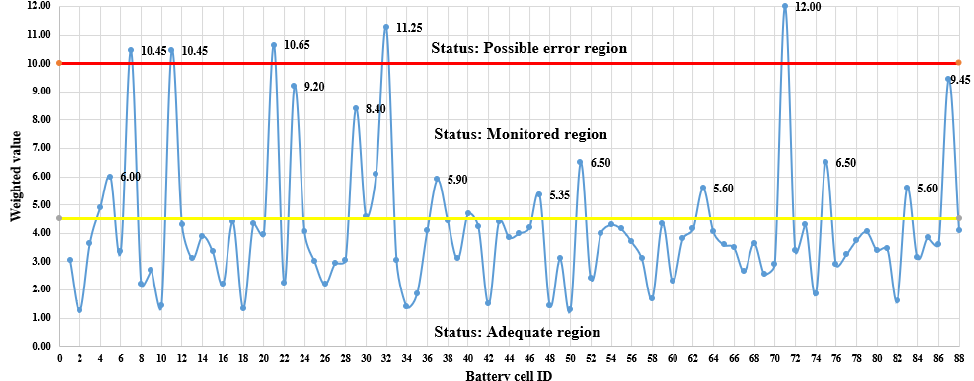
Figure 15. Aggregated error factor assigned to the cell identifier in the cyclical measurement. In Figure 15, the error factor cut-offs are set at 10% and 5% of the data set. The possible error category was assigned to the cell IDs, which were detected with an average voltage higher than 10% based on the aggregate measurement results (results above the red line). Cells flagged for further monitoring were more than 5% but less than 10% below the average voltage based on the summary results (the values between the red and yellow lines). In the adequate region, they were below the mean voltage by less than 5% of the time (values below the yellow line). Based on the outcomes, it can be stated that five dif- ferent cells caused real outliers. The evaluation of the results and comparison with the previous ones will be presented in the discussion section (Section 4).